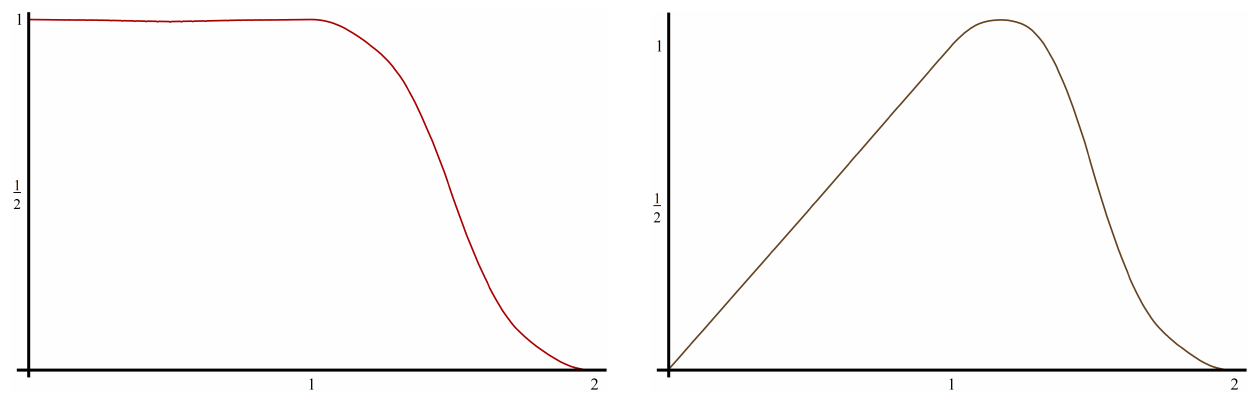
and φ , from Example L, 0 L, 1